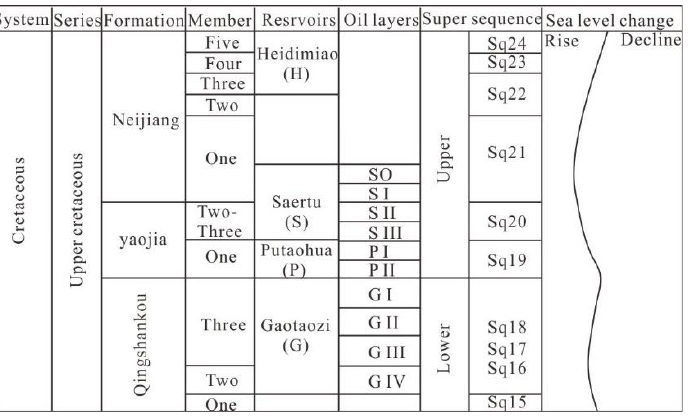
Figure 2. Characteristics of the stratigraphic framework of the Daqing Changyuan oilfield.